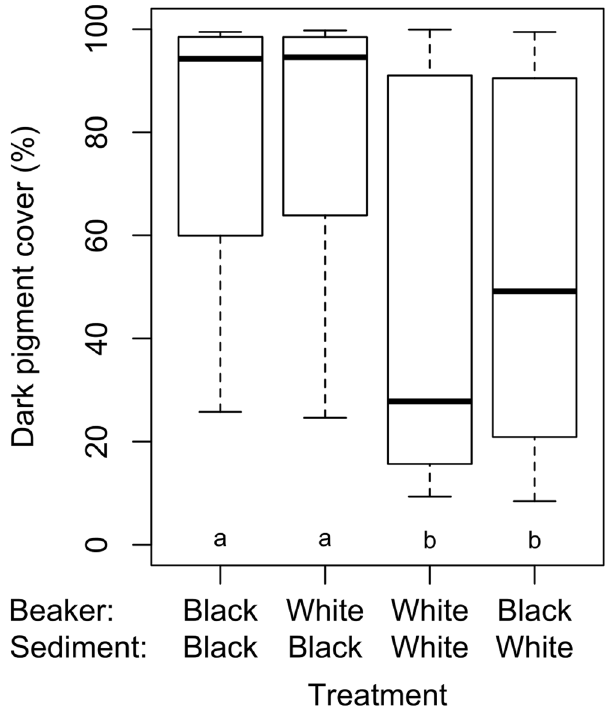
Figure 5. Box-and-whisker plots of dark pigment cover (%) of Crangon crangon (N = 32) kept for 24 h in beakers with different combinations of sediment and beaker colours. Different letters indicate groups that are significantly different (P < 0.01) based on Dunn-Bonferroni corrected post-hoc analyses.